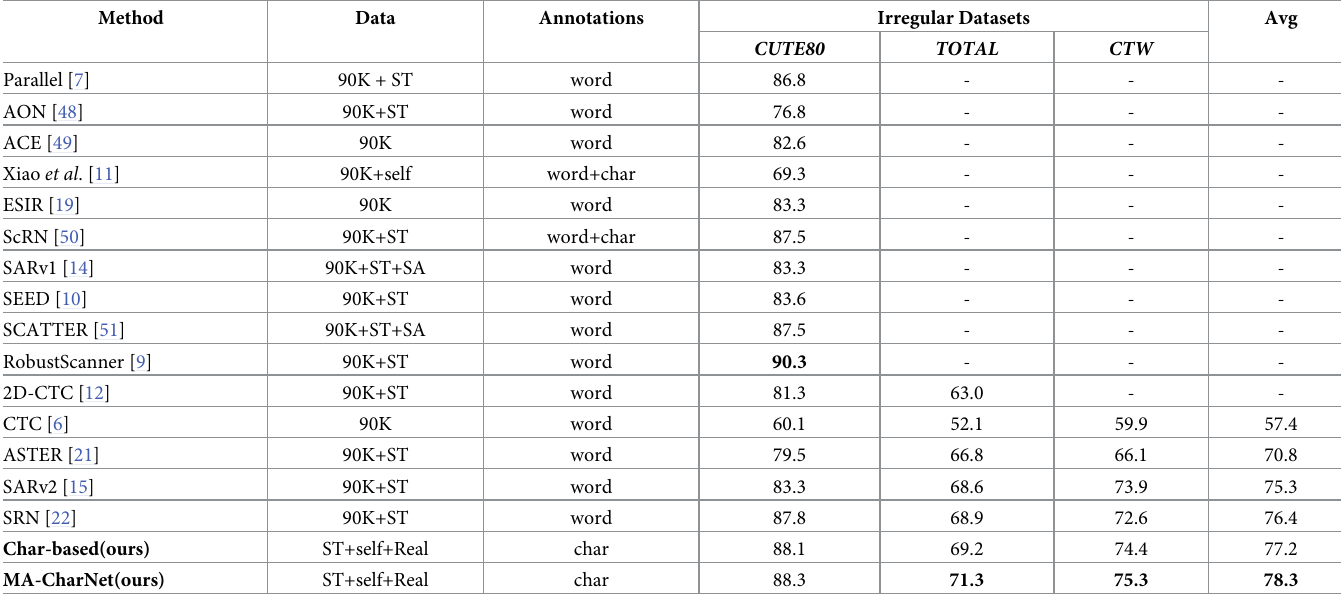
The used training data and annotations are shown in columns ‘Data’ and ‘Annotations’, where ‘90K’, ’ST’, ’SA’, ’self’ refer to Synth90K dataset, SynthText dataset, SynthAdd dataset, self-made dataset, respectively. And ‘Real’ refer to the dataset we mentioned in Sec.4.1. ‘Avg’ denotes the average of the performance on the three irregular datasets. Note that all results are obtained without lexicon. Note that dataset CUTE80 only consists of 288 word samples. Besides, it only contain a negligible proportion of irregular text samples [52]. However, MA-CharNet is designed for the recognition of irregular text, so our performance on CUTE80 is insufficient.